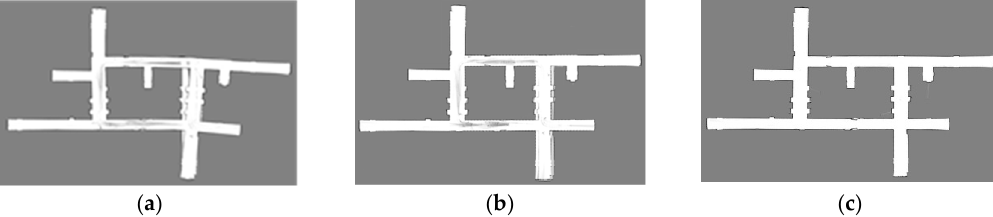
Figure 7. Maps built in open-loop scene (inside the corridor area, the darker the area was, the more blurry it was, that is, the lower quality it will be). ( a ) A map built with Cartographer with LiDAR only; ( b ) a map built with Cartographer with LiDAR+IMU fusion; ( c ) a map built with the proposed method. Figure 8. Evaluation experiments in closed-loop scene. ( a ) A map created by Cartographer with LiDAR only; ( b ) a map created by Cartographer with LiDAR+IMU fusion; ( c ) a map created by the proposed method.